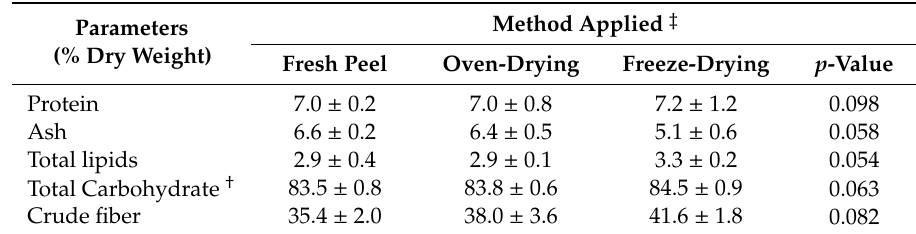
Table 1. Proximate composition of dehydrated BRS magna grape skin residue using conventional oven-drying and freeze-drying